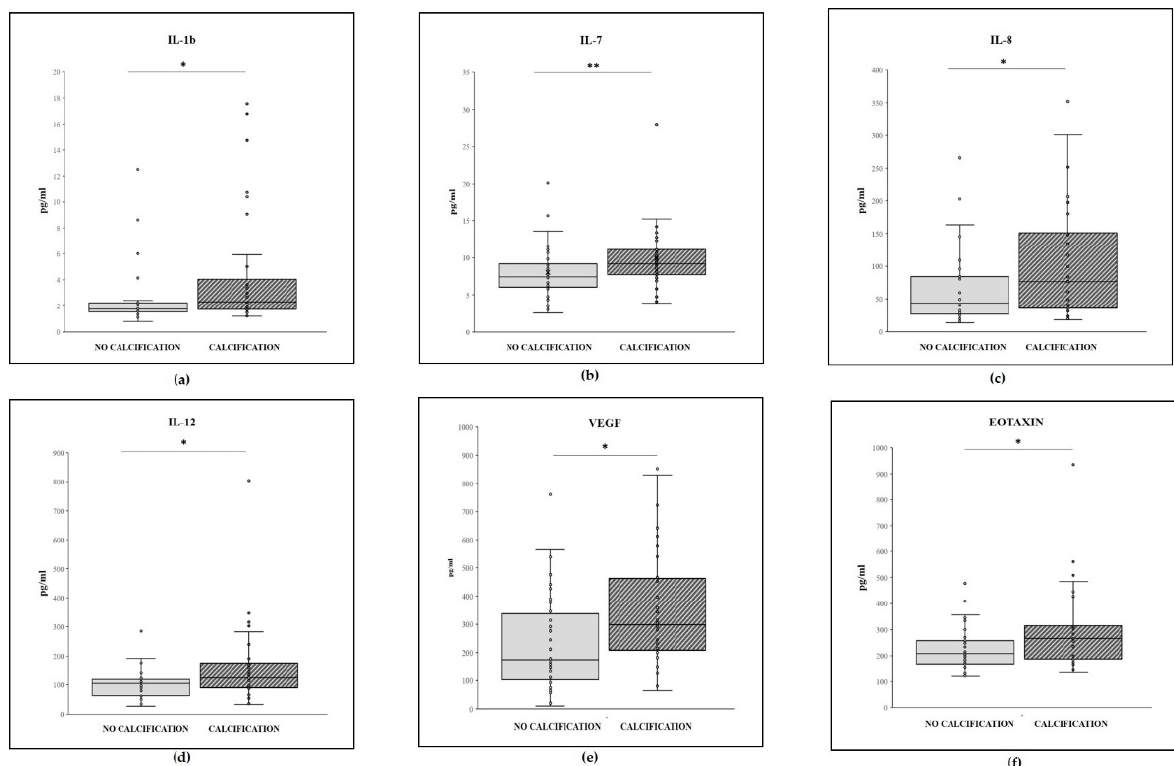
Figure 4. Box plot of plasma level (pg/mL) of ( a ) IL-1b, ( b ) IL-7, ( c ) IL-8, ( d ) IL-12, ( e ) Eotaxin, and ( f ) VEGF (pg/mL) in patients with no calcification (Agatston score 0, n = 34; 45.9%) and those with calcification (Agatston 1 + 2 + 3, n = 40; 54.1%). Within each box (25th; 75th percentile), the horizontal black lines represent the median values; points outside the whiskers represent outliers, i.e., measurements outside the median ± 1.5 × (75th percentile–25th percentile). p -values * <0.05 ** <0.01, according to Mann–Whitney U test.